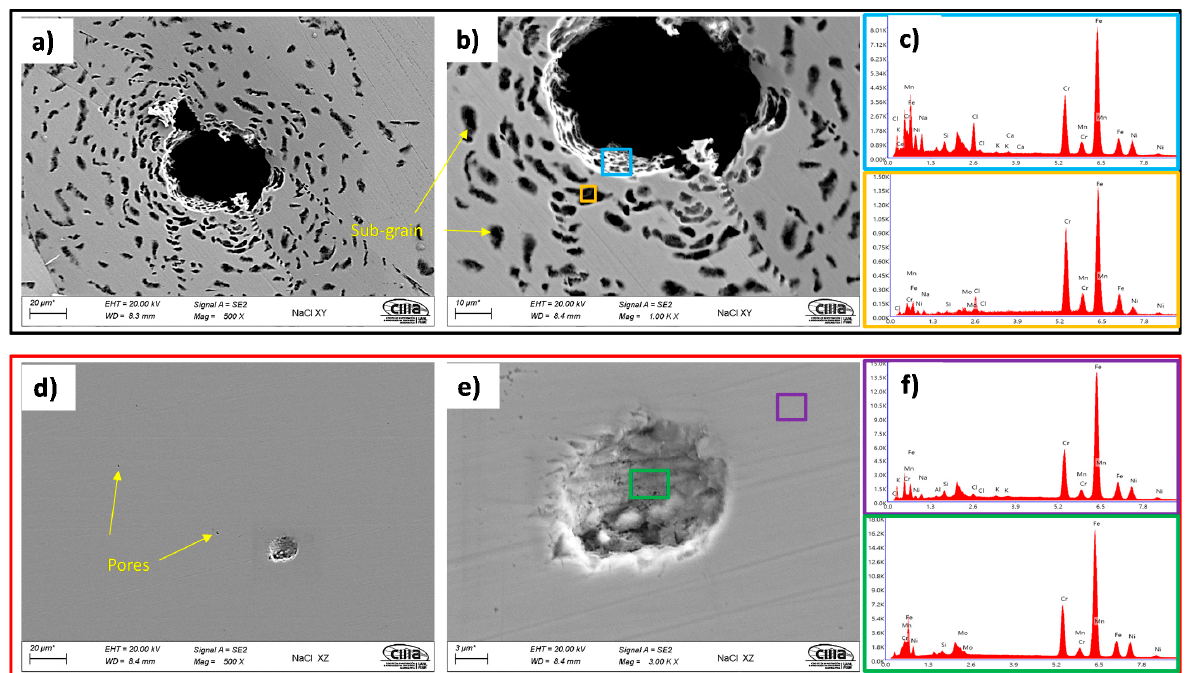
Figure 13. Morphologies of the specimens after the electrochemical tests in 3.5 wt.% NaCl at 500X and 1000X. XY plane ( a , b , c ); XZ plane ( d , e , f ). ZEISS EVO scanning electron microscope (SEM).